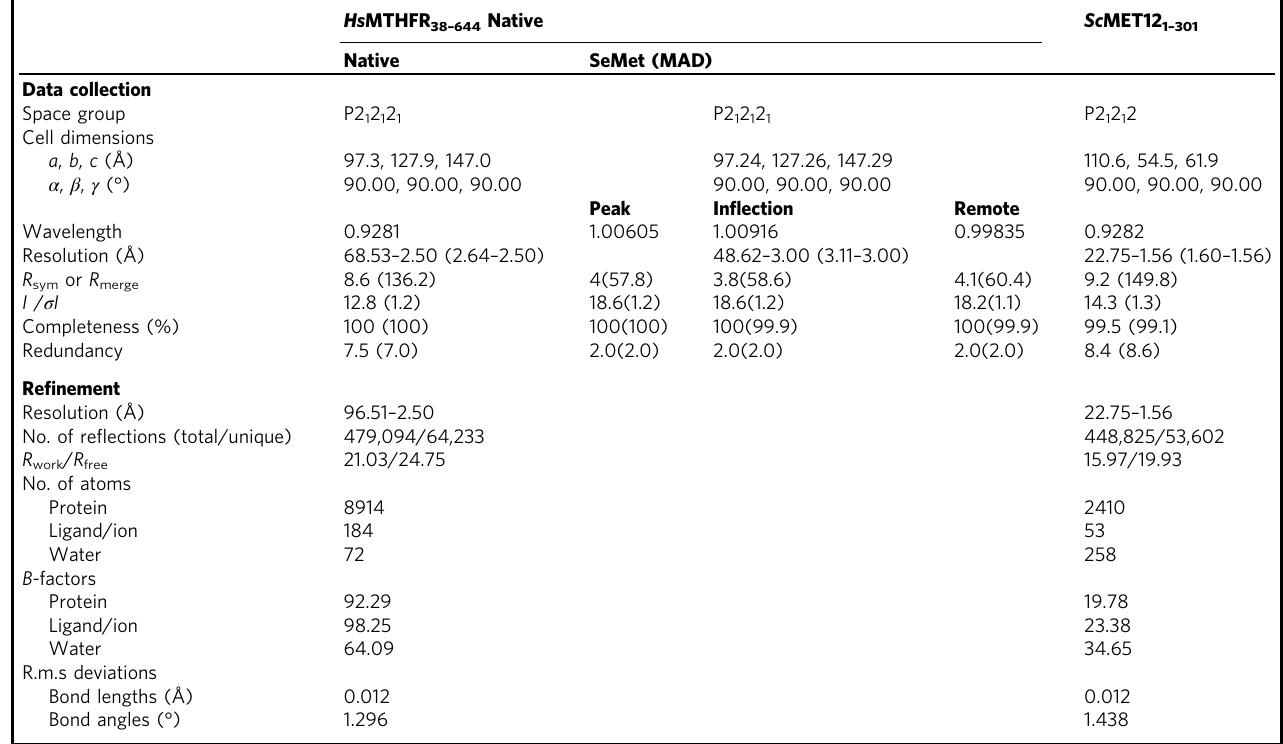
Table 2 Data collection and re fi nement